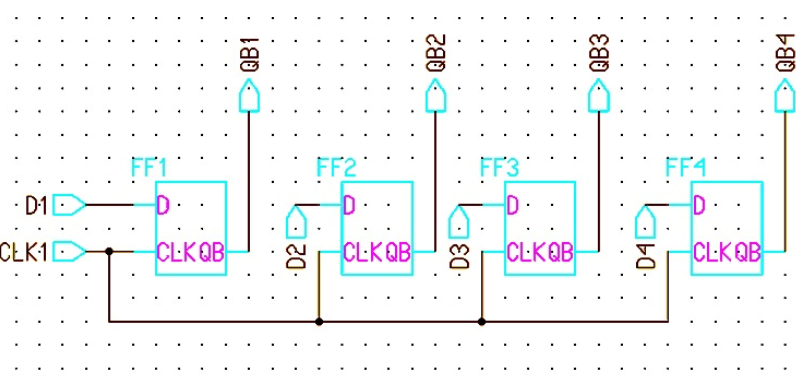
Figure 7. Schematic of the four-bit parallel in-parallel out (PIPO) shift register. Electronics 2016 , 5 , 92